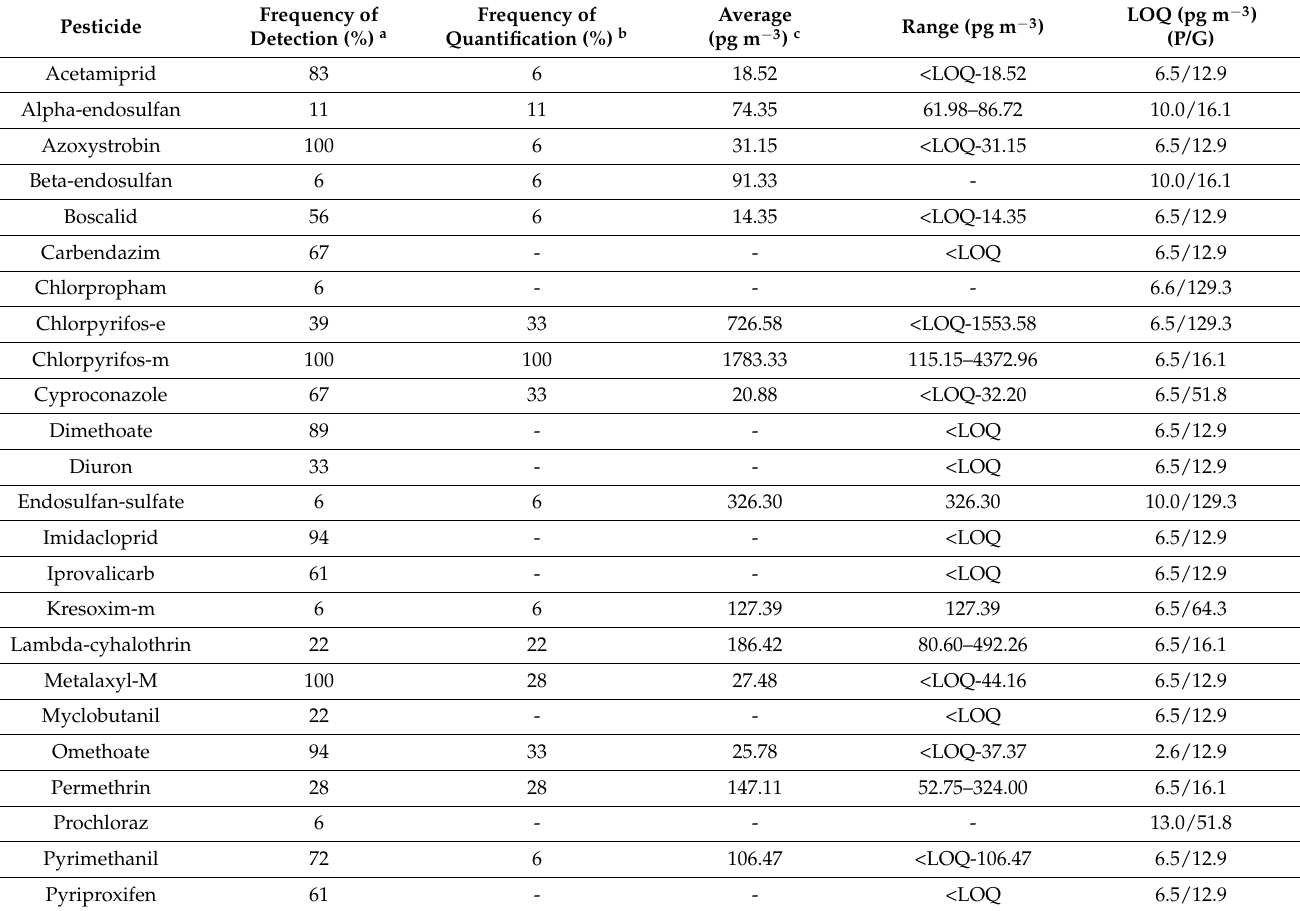
Table 2. Overall concentrations (P + G) detected in all sampling sites of the pilot scheme ( N = 18).